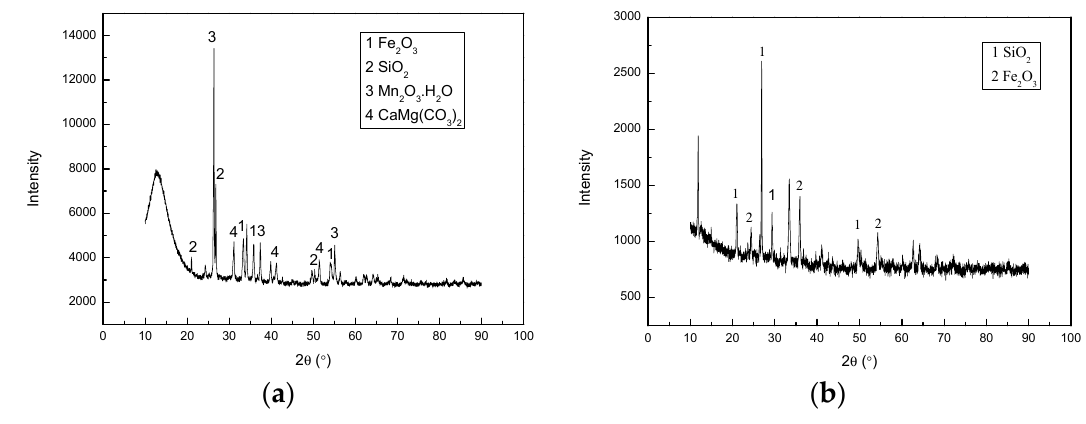
Figure 1. X-ray diffraction (XRD) pattern ( a ) manganese ore; and ( b ) leaching residue.